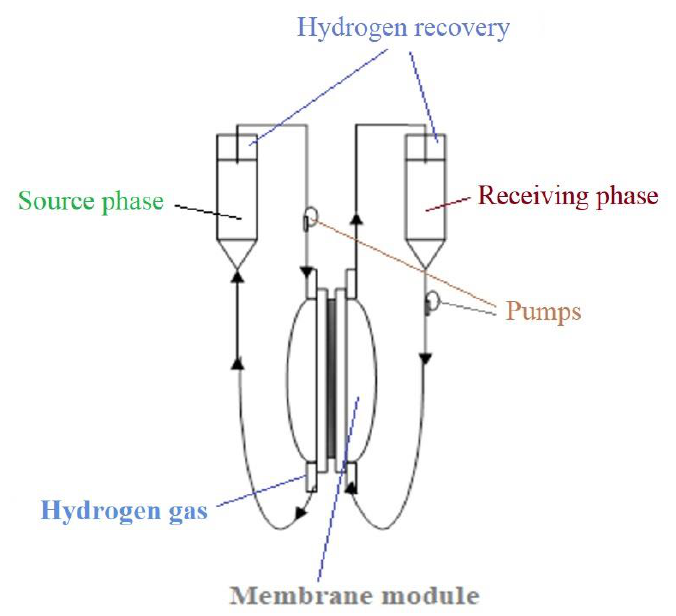
Figure 5. The schematic presentation of the reduction installation of 5 – nitrobenzimidazole to 5 – aminobenzimidazole.